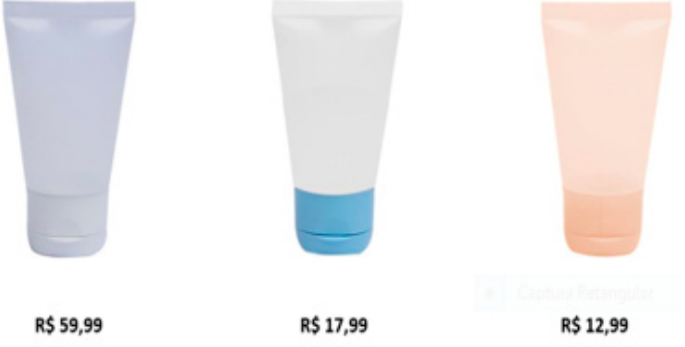
Figure 4. Slide B—Transparent tubes with prices. Source: the authors (2020).